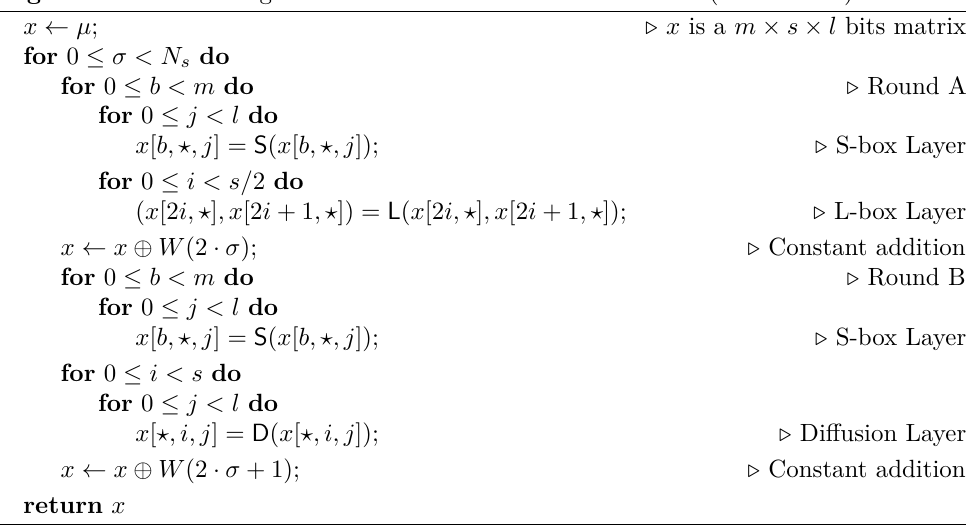
Algorithm 2 m LS-design with 2 l -bit L-boxes and s -bit S-boxes ( n = m · s · l )